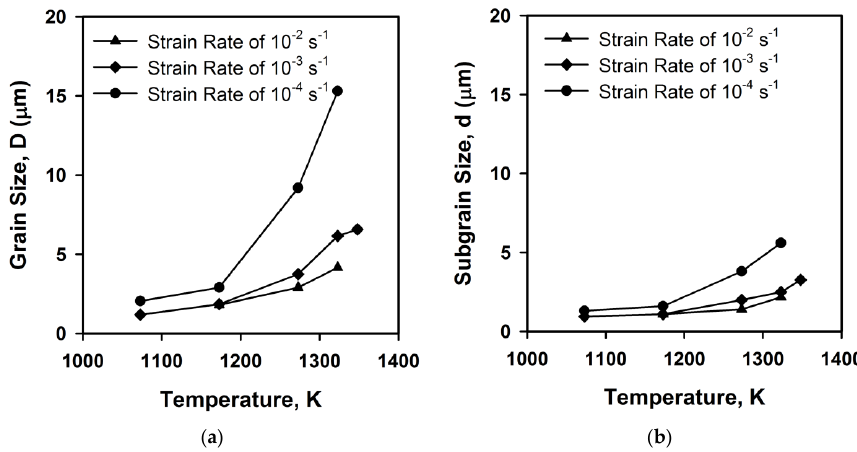
Figure 4. DRX grain ( a ) and subgrain ( b ) size that evolved in the high-nitrogen austenitic stainless steel during compression at different temperatures and strain